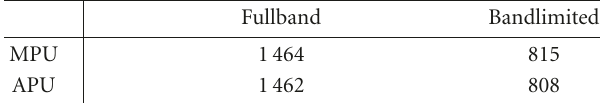
Table 4: The comparison of computation loading of the fullband CCS and the bandlimited CCS with fast